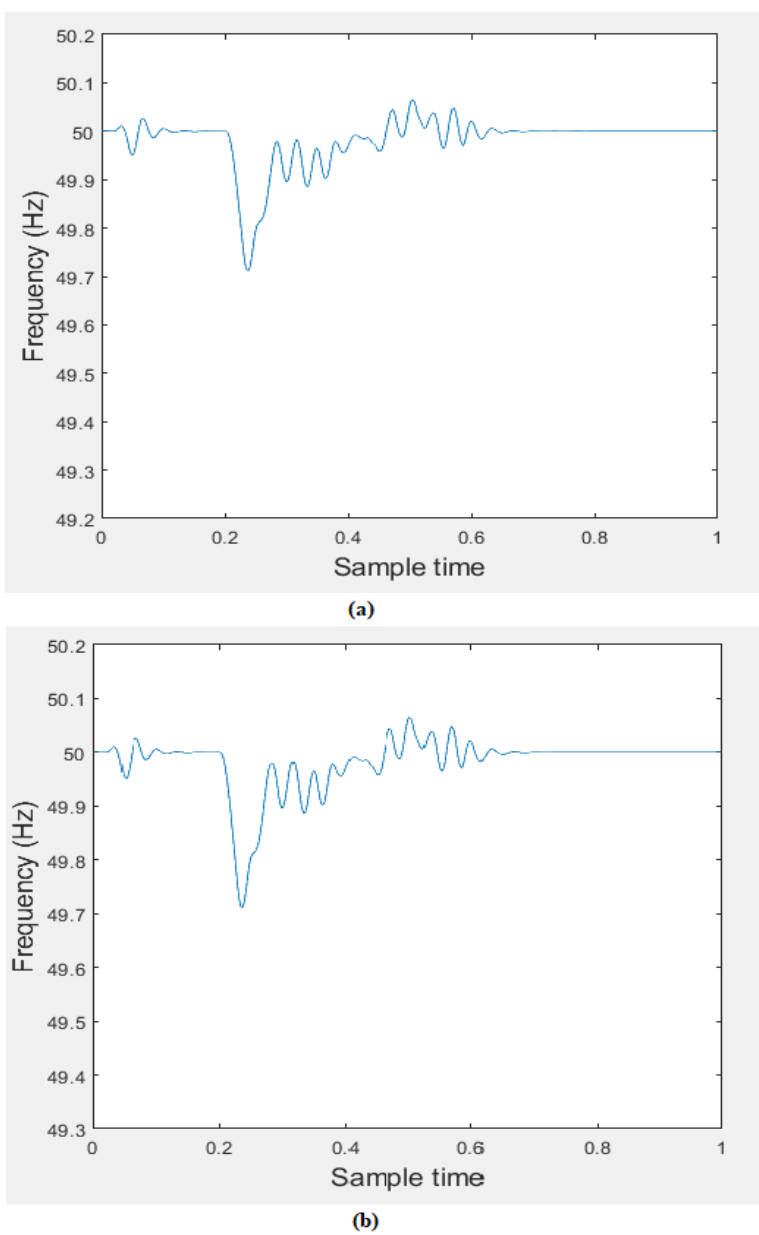
Figure 11. Frequency signal: ( a ) MG 1 , ( b ) MG 2.